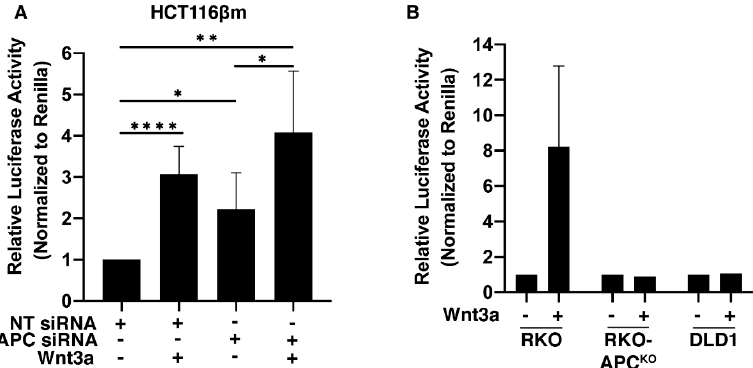
Figure 4. The Wnt transcriptional program is induced in HCT116 β m upon Wnt-3a treatment or APC-depletion. ( A ) HCT116 β m cells were cotransfected with pTOPflash and pRenilla luciferase reporter plasmids as well as control-siRNA or APC-siRNA, and subsequently treated with 125 ng Wnt3a for 24 h. Data averaged from seven individual experiments. Relative luciferase activity determined by the TOPflash / Renilla ratio of each group, followed by normalization to the control. Error bars, SD; Statistical analysis by t -test: * p < 0.05; ** p < 0.01; **** p < 0.0001. ( B ) TOPflash reporter assay in RKO, RKO-APC KO , and DLD-1 colorectal cancer cell lines. Data for RKO averaged from